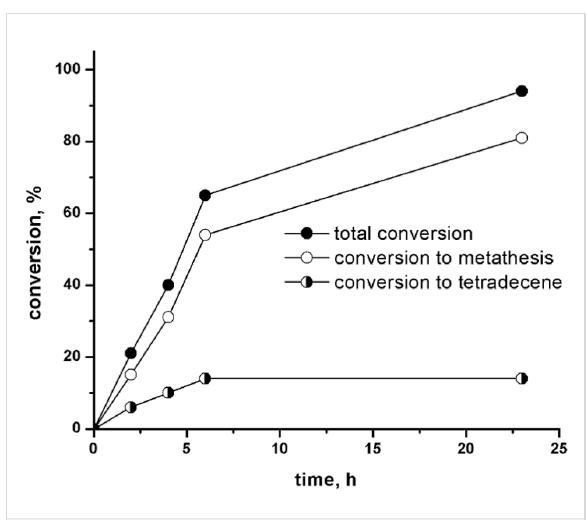
Figure 3: Conversion vs time curves for the 1-octene metathesis over 6MoO 3 /MCM-56(13). Neat 1-octene, 1-octene/Mo = 320, t = 40 °C.